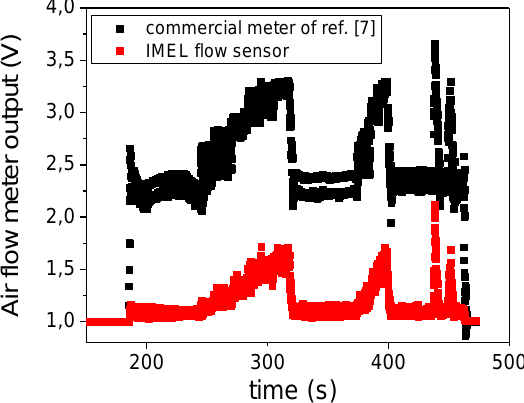
Figure 10. Air flow meter output as a function of time for the above presented air flow meter (red open squares) and the commercial meter of [7] used (black squares). The response of the two systems was monitored by arbitrarily pushing the gas